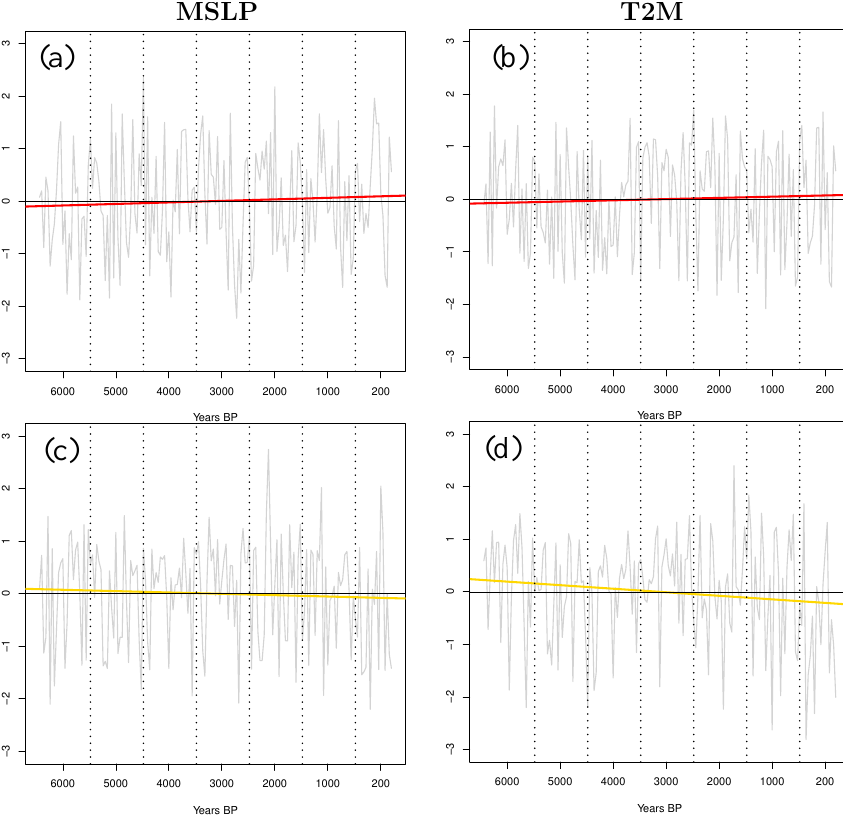
Figure 12. Canonical score series of the first two pairs of canonical correlation patterns of, respectively, MSLP (left column) and 2m temperature (right column) winter seasonal mean